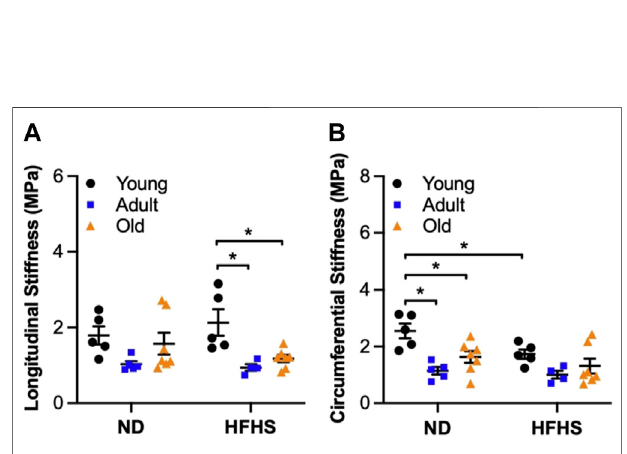
FIGURE 6 | Average (mean ± SEM) material stiffness at MAP in longitudinal (A) and circumferential (B) direction as a function of age (young, adult, and old) and diet (ND and HFHS) (* p <